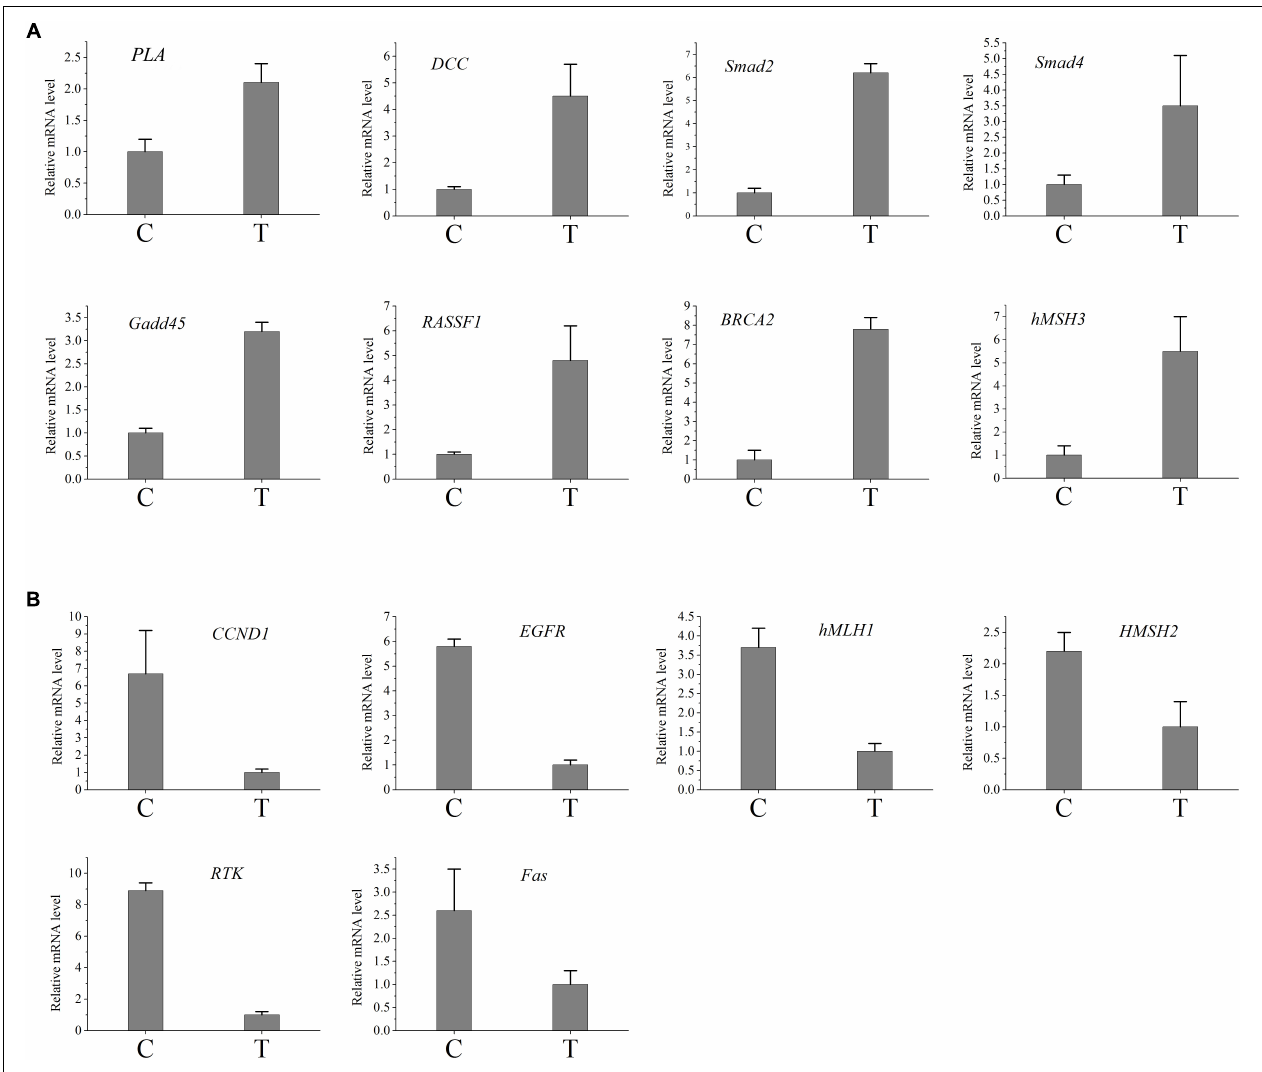
FIGURE 4 | Validation of the difference in expression of the genes using qRT-PCR. (A) The qRT-PCR results of the up-regulated genes in infected group. (B) The qRT-PCR results of the down-regulated genes in infected group. C, control group; T, treated